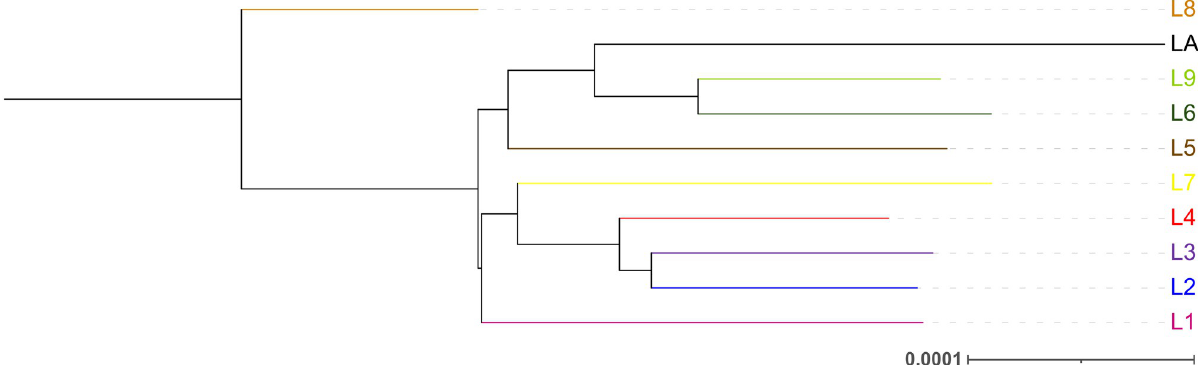
Fig 1. The phylogenetic structure of the MTBC. Phylogenetic analysis of 10 MTBC genomes selected to include 1 genome from each of the known MTBC lineages (accession numbers: SRR1162469, ERR2704812, ERR181314, SRR10828835, ERR1193734, SRR8237291, ERR3470572, ERR3470655, ERR756344, and ERR015582). A maximum likelihood tree was created with IQ-TREE v2.1.2 using TVM+F+I (the best-fit model of substitution according to AIC). The tree was coloured using iTOL 6.5.2 with the commonly used colour scheme for the different MTBC lineages: Lineage 1 (L1) in pink; Lineage 2 (L2) in blue; Lineage 3 (L3) in purple; Lineage 4 (L4) in red; Lineage 5 (L5) in brown; Lineage 6 (L6) in green; Lineage 7 (L7) in yellow; Lineage 8 (L8) in light brown; Lineage 9 (L9) in light green; and animal-associated lineages (LA) in black. Strains from L1–L4 and L8 are considered M . tuberculosis sensu stricto and L5, L6, and L9 M . africanum . The scale bar indicates the number of nucleotide substitutions per site. AIC, Akaike information criterion; MTBC, Mycobacterium tuberculosis complex.